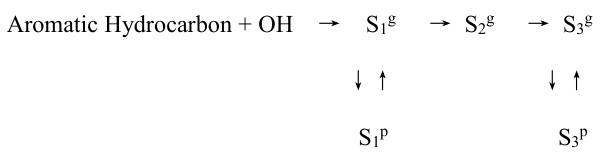
Figure 8. Kinetic scheme for SOA formation from monocyclic aro- matic